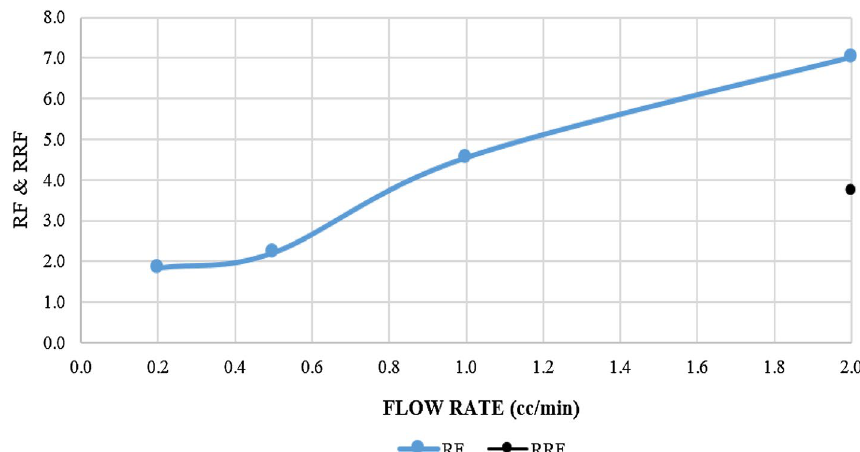
Fig. 4 RF and RRF data as function of flow rates in cc/min during Exp.1